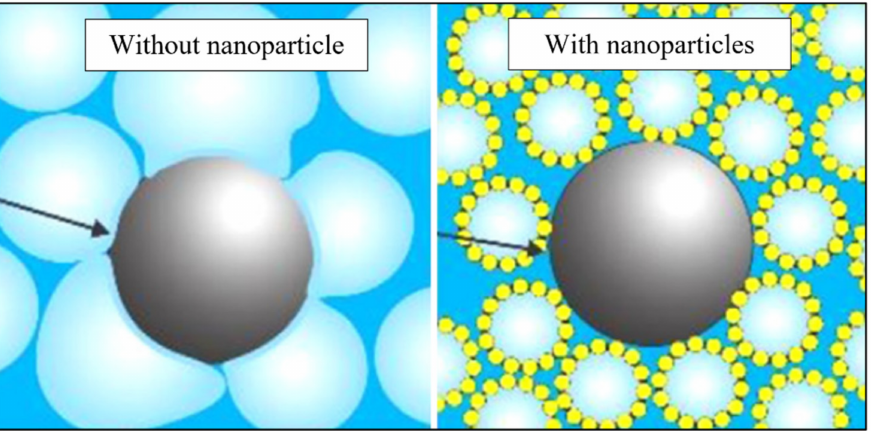
Figure 29. Illustration of proppant suspension in foam with and without nanoparticles (Adapted with permission from Fei et al. [39]). Copyright 2017, The Korean Society of Industrial and Engineering Chemistry. Published by Elsevier